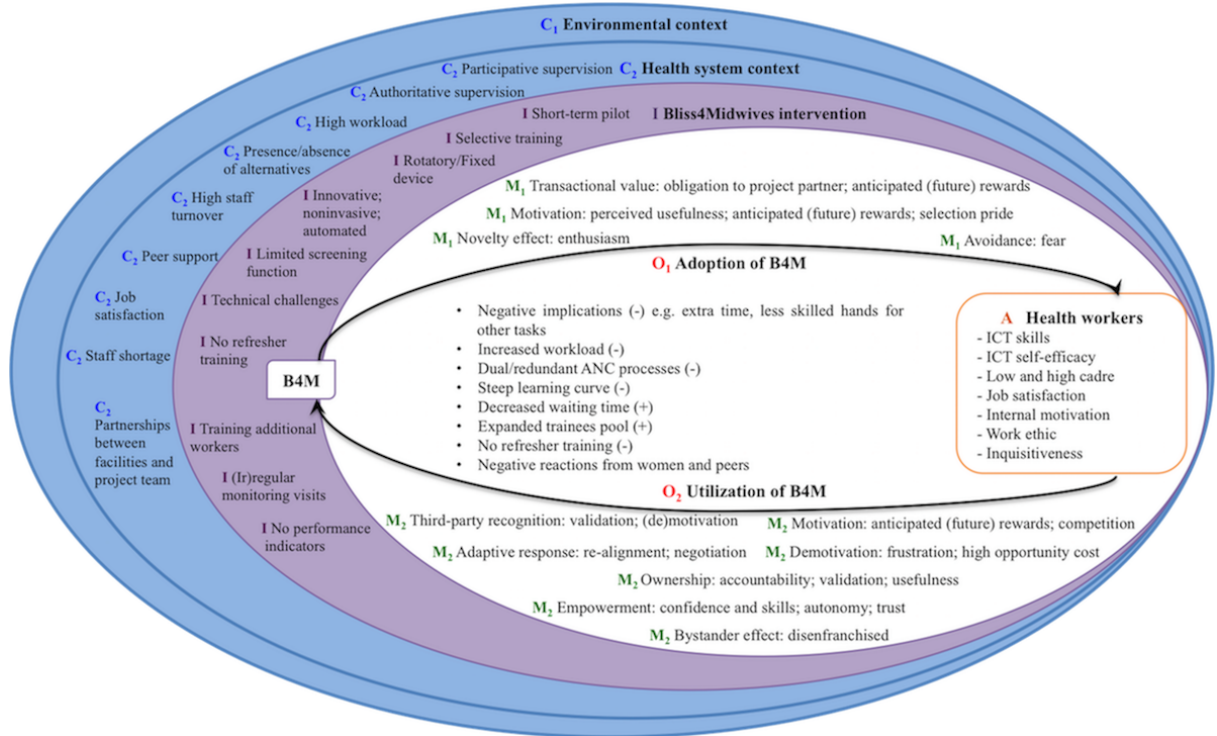
Figure 2. Summary of findings. Ecosystem of ICAMO factors underlying the adoption (O 1 ) and utilization (O 2 ) of B4M within a complex context (concentric circles C 1 and C 2 ) and features of the B4M intervention (I). M 1 and M 2 are mechanisms related to outcomes O 1 and O 2 , mediated by user characteristics (A). Bullet points highlight other facilitating (+) or inhibitory (–) factors influencing usage behavior. ANC: antenatal care;